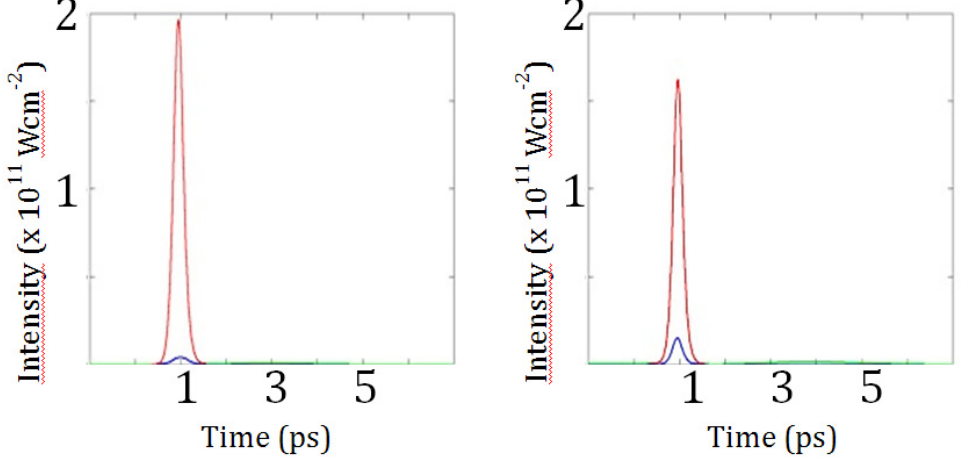
Figure 5. Left , temporal evolution of the HHG intensity at the first plasma entrance (blue) and at its exit (red) ( cf Figure 3). Right , same image but at the entrance and exit of the main amplifier. One can observe although ASE exists in both cases, the optimized seeding conditions allow it to be kept at a negligible